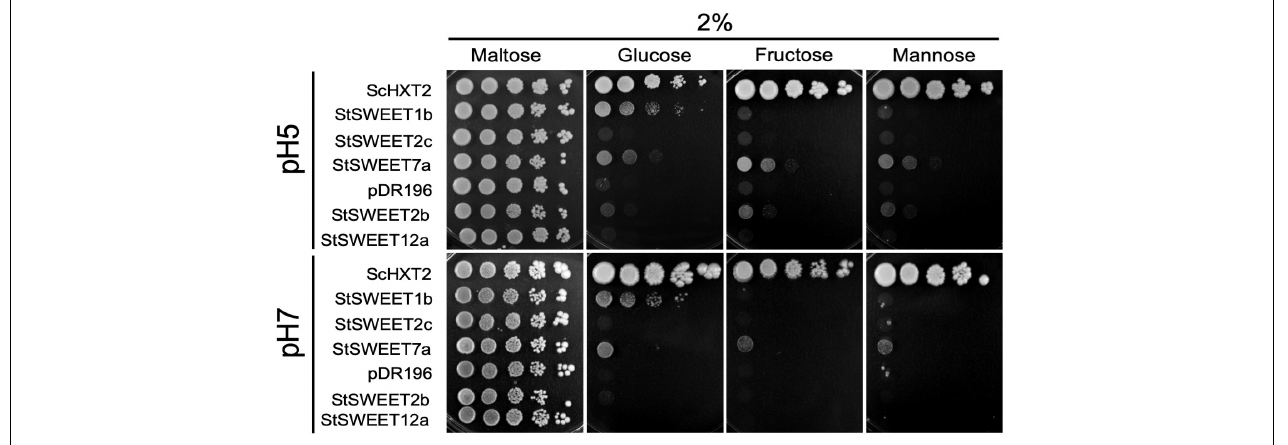
FIGURE 2 | Analysis of the monosaccharide transport ability of five S. tuberosum SWEETs in yeast at pH 5 and pH 7. The EBY.VW4000 yeast strain was transformed with an empty vector (pDR196) or with the positive control ScHXT2 or with the potato transporters StSWEET1b , StSWEET2b , StSWEET2c , StSWEET7a , or StSWEET12a , all cloned in pDR196. Strains were plated on SD medium without uracil supplemented with 2% maltose (growth control) or with 2% D -fructose, D -glucose, or D -mannose. Plates were incubated at 28 ◦ C for 5 days (pH 5) or for 12 days (pH